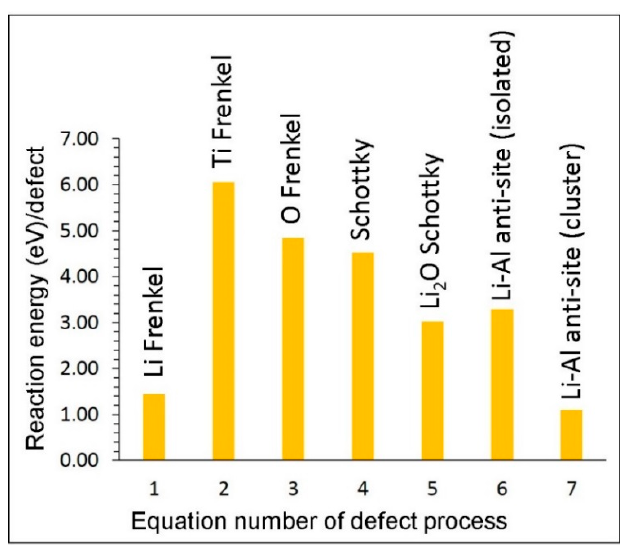
Figure 2. Energetics of intrinsic defect process calculated in tertragonal LiAlO 2.